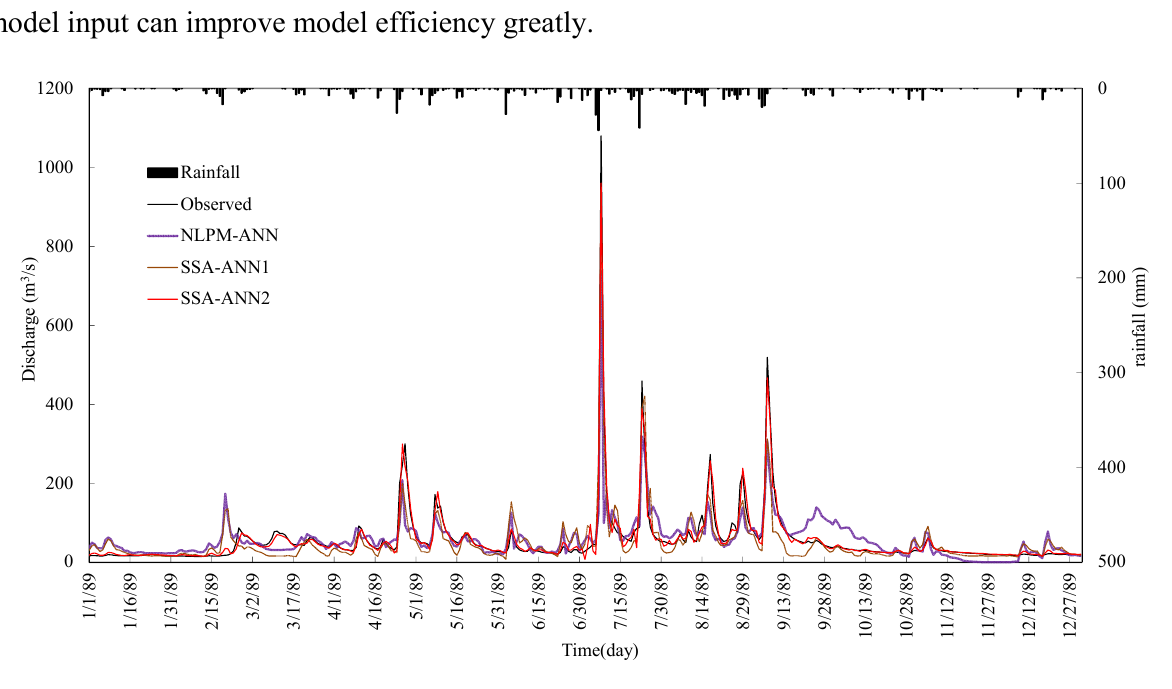
Figure 6. Observed and simulated runoff hydrographs by three models for Jiahe.